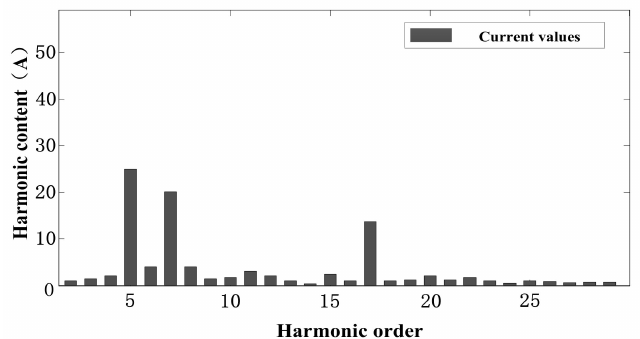
Figure 11. The rotor current